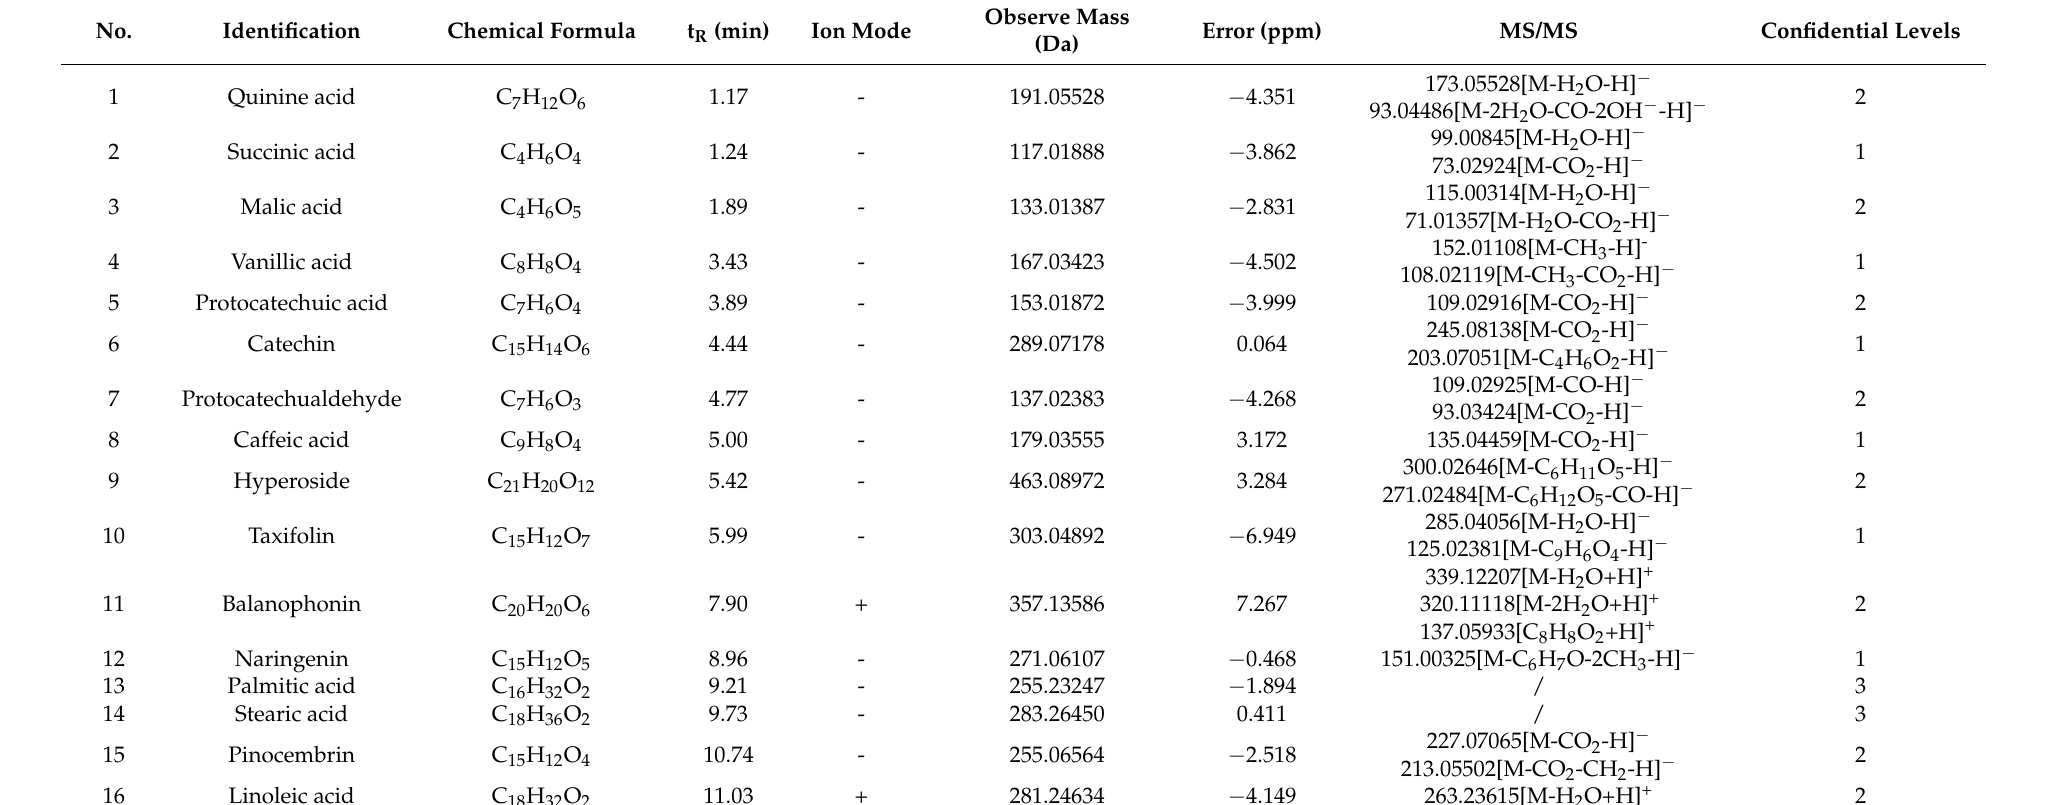
Table 2. Identification of elution solution by UHPLC-Q-Exactive